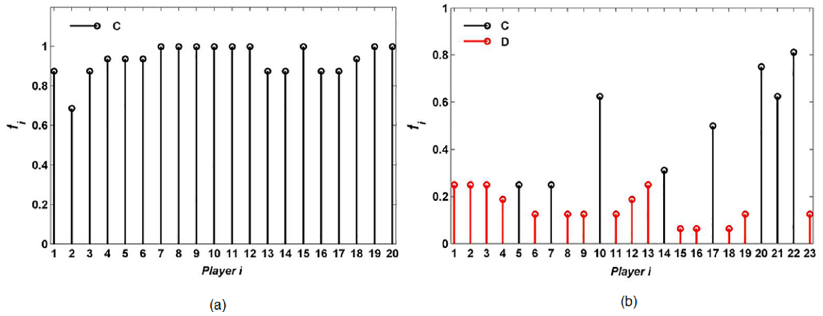
Fig 7. Frequency of the cooperative interacting-neighbors of high-connectivity players under (a) random interaction and (b) high-degree preference interaction. Cooperator is denotedby C with black and defector by D with